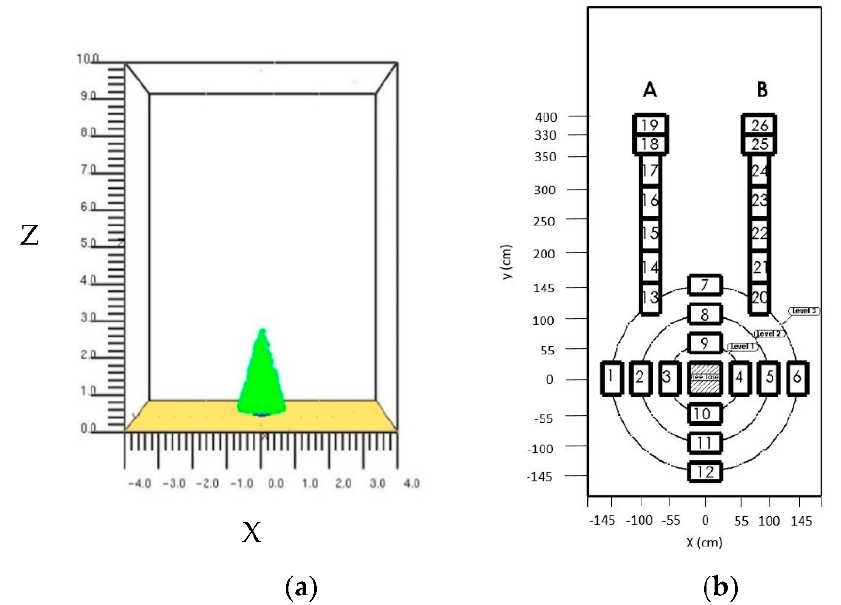
Figure 1. ( a ) Smokeview snapshot of the model tree (at 0 s time). ( b ) Plan view of the firebrand collection tray arrangement. Each tray is numbered 1 to 26 and the tree base is at the middle of 3–4 and 9–10 trays. A, B are the parallel branches of the tray arrangement. The trays are categorized into three levels presented as circles where the level 1 is the closest to tree base and level 3 is the farthest. Table 2. Composition and physical properties of burnable fuel of Douglas fir tree measured at NIST [27].